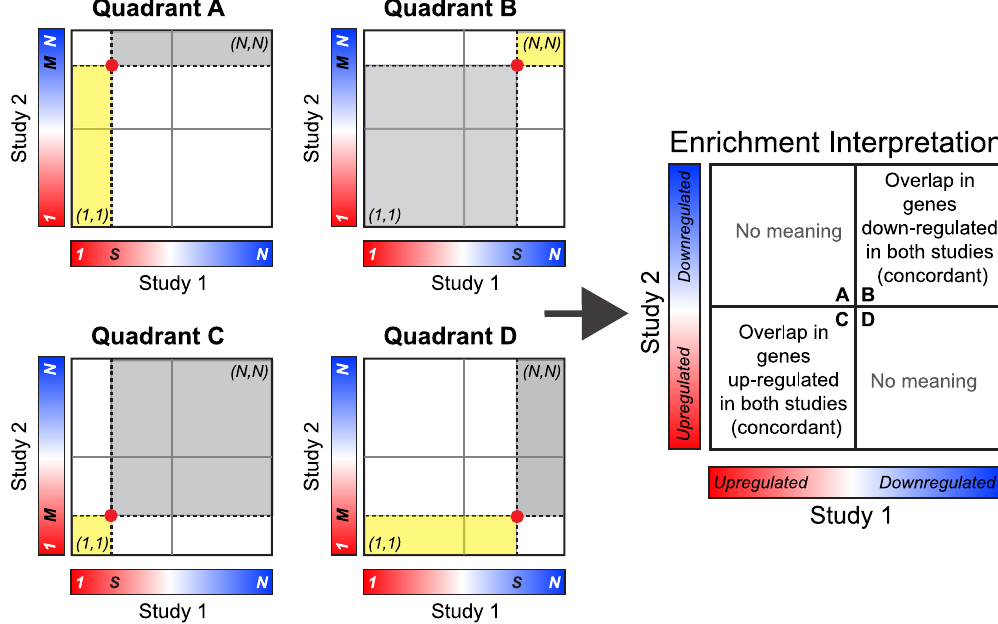
Figure 2. Interpretation of RRHO Enrichment method. A significant heatmap signal in either quadrants B or C is intuitive, representing overlap in genes changed in the same direction in the two studies. However, interpretation of signal in quadrants A or D is not intuitive. For instance, a signal in quadrant A indicates overlap in genes up-regulated in study 1 with genes that are down-regulated, not changed, and up-regulated in study 2. Similarly, a signal in quadrant D indicates overlap in genes up-regulated in study 2 with genes that are down-regulated, not changed, and up-regulated in study 1. Thus, using the enrichment method, signal in quadrant A or quadrant D is not